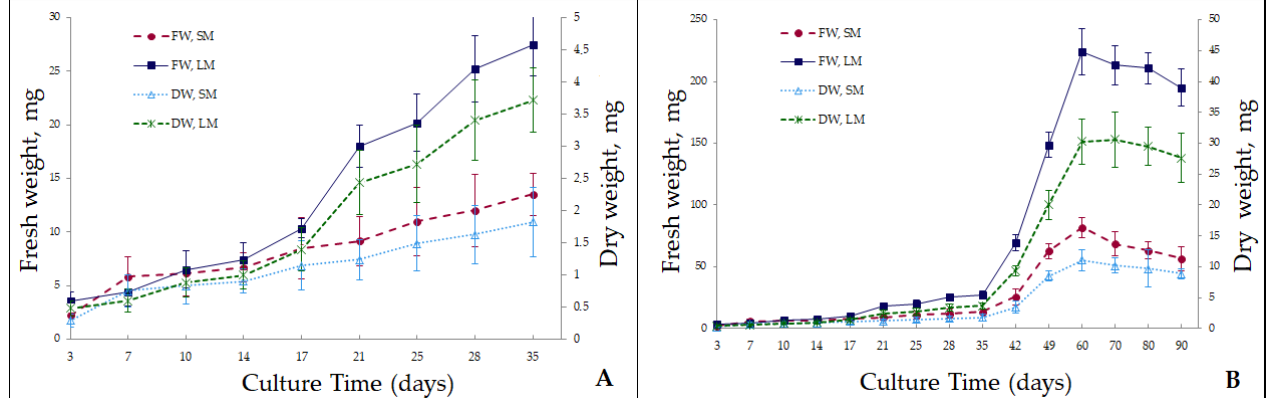
Figure 1. The growth curve for S. betulifolia ssp. aemiliana microshoots in hormone-free MS solid (agar) and liquid media for ( A ) 35-day ( B ) and 90-day cultivation. FW SM: fresh weight for the solid medium; FW LM: fresh weight for the liquid medium; DW SM: dry weight for the solid medium; DW LM: dry weight for the liquid medium.